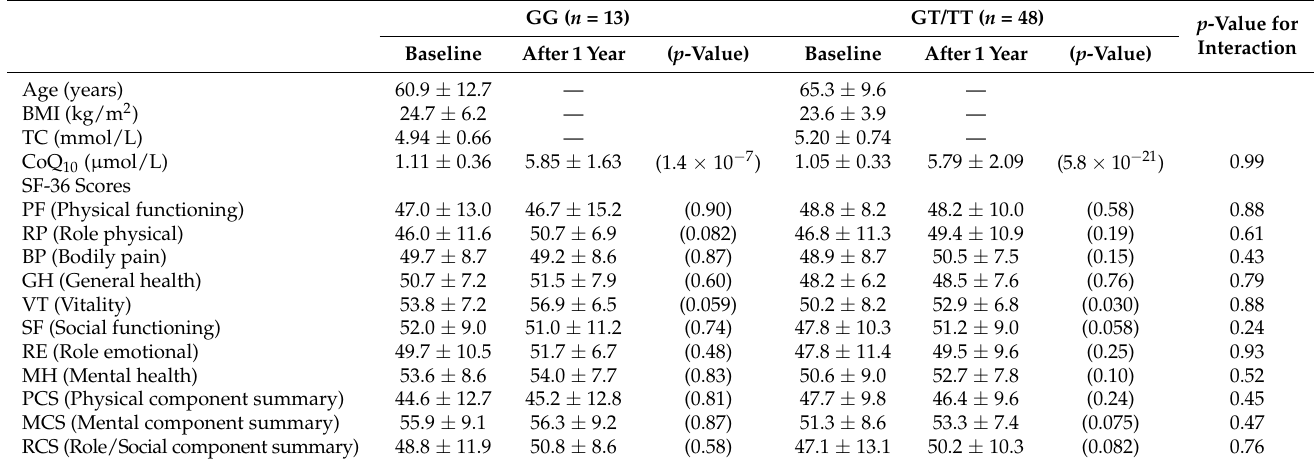
Table 4. Changes in the measurements of rs2032582 (G > T) in ABCB1 during the reduced CoQ 10 supplementation in